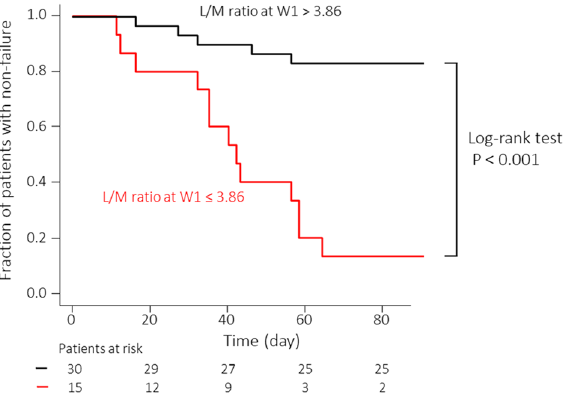
Figure 2. Kaplan–Meier time-to-relapse curve of patients with ulcerative colitis (UC) in relation to the leukocyte to monocyte (L/M) ratios > 3.86 and ≤ 3.86.